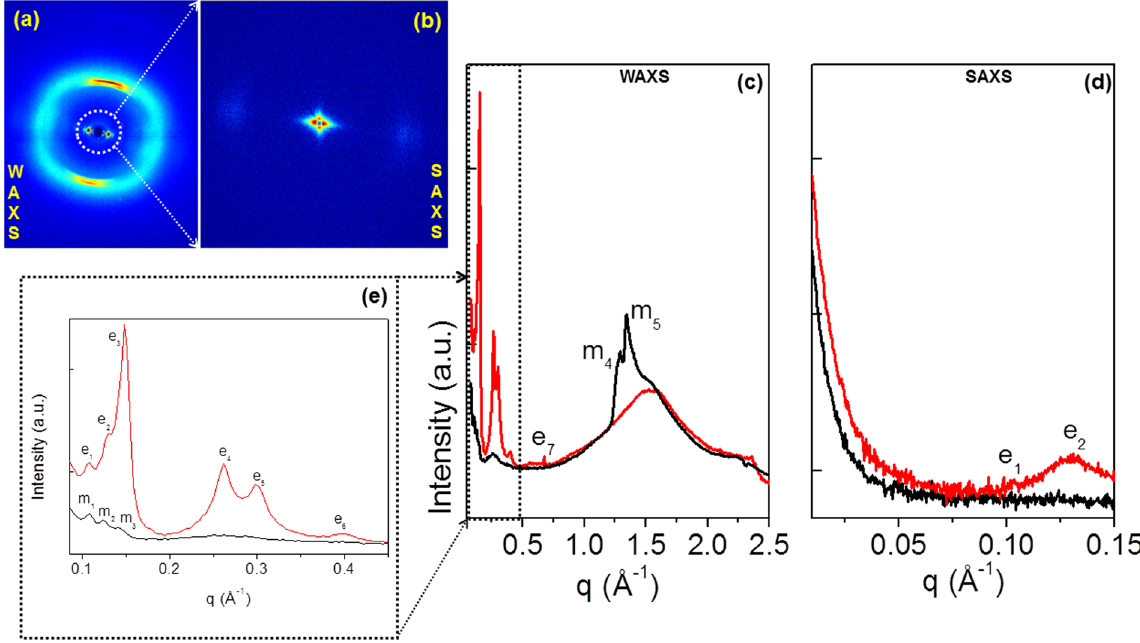
Figure 5. 2Nal 2 fiber at solid state: ( a , b ) 2D WAXS and SAXS data; ( c , d ) 1D WAXS and SAXS profiles (red and black corresponding to the meridional and equatorial directions) as obtained once the corresponding 2D WAXS ( a ) and SAXS ( b ) data are centered, calibrated and radially folded; the inset in panel ( d ) refers to the equatorial e2 reflection, with an estimated FWHM (e2-2Nal